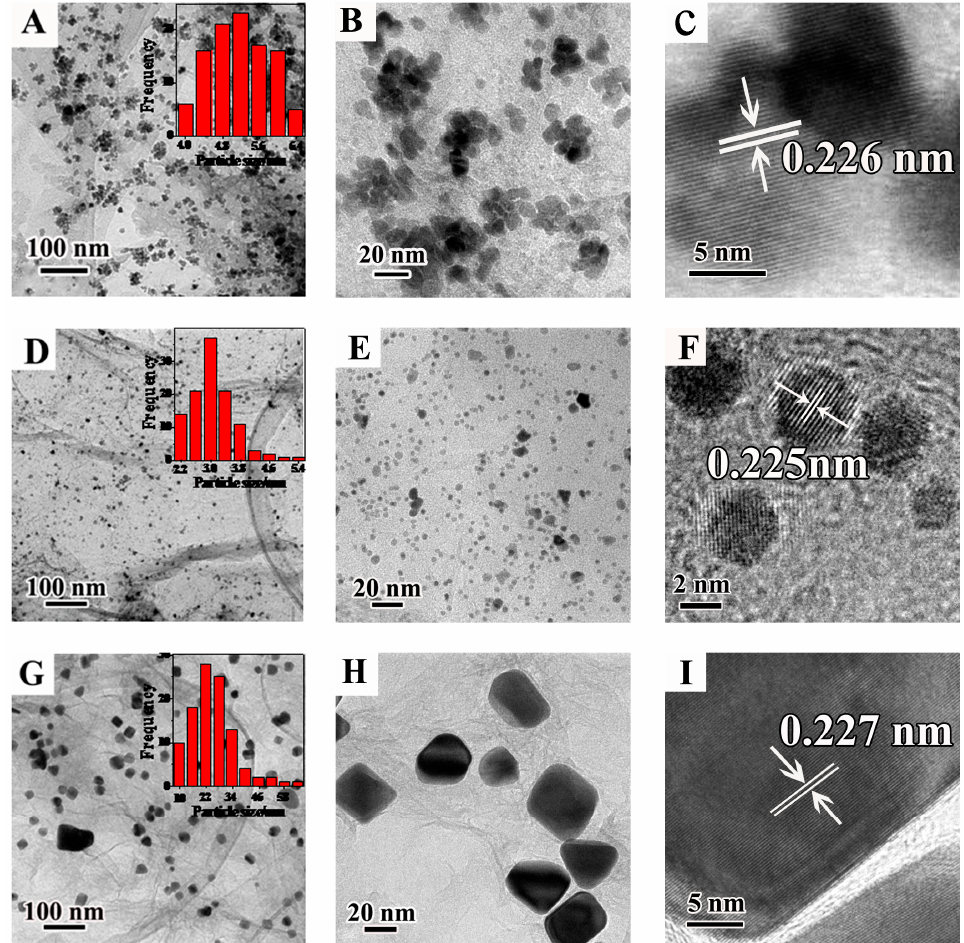
Figure 2. TEM images of Pt/GNs (PAMAM) ( A , B ); Pt/GNs (CS) ( D , E ); Pt/GNs ( G , H ). Size-distribution of Pt particles in Pt/GNs (PAMAM) (the inset of ( A )); Pt/GNs (CS) (the inset of ( D )); Pt/GNs (the inset of ( G )). HRTEM images of Pt particles in Pt/GNs (PAMAM) ( C ); Pt/GNs (CS) ( F ); Pt/GNs ( I ).